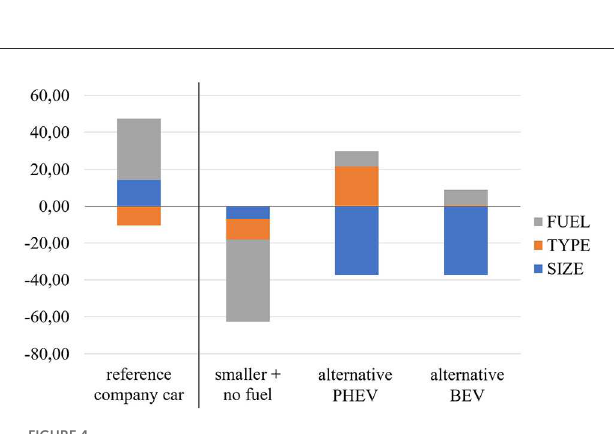
FIGURE4 Summed utilities for the current company car standard, compared with three more sustainable